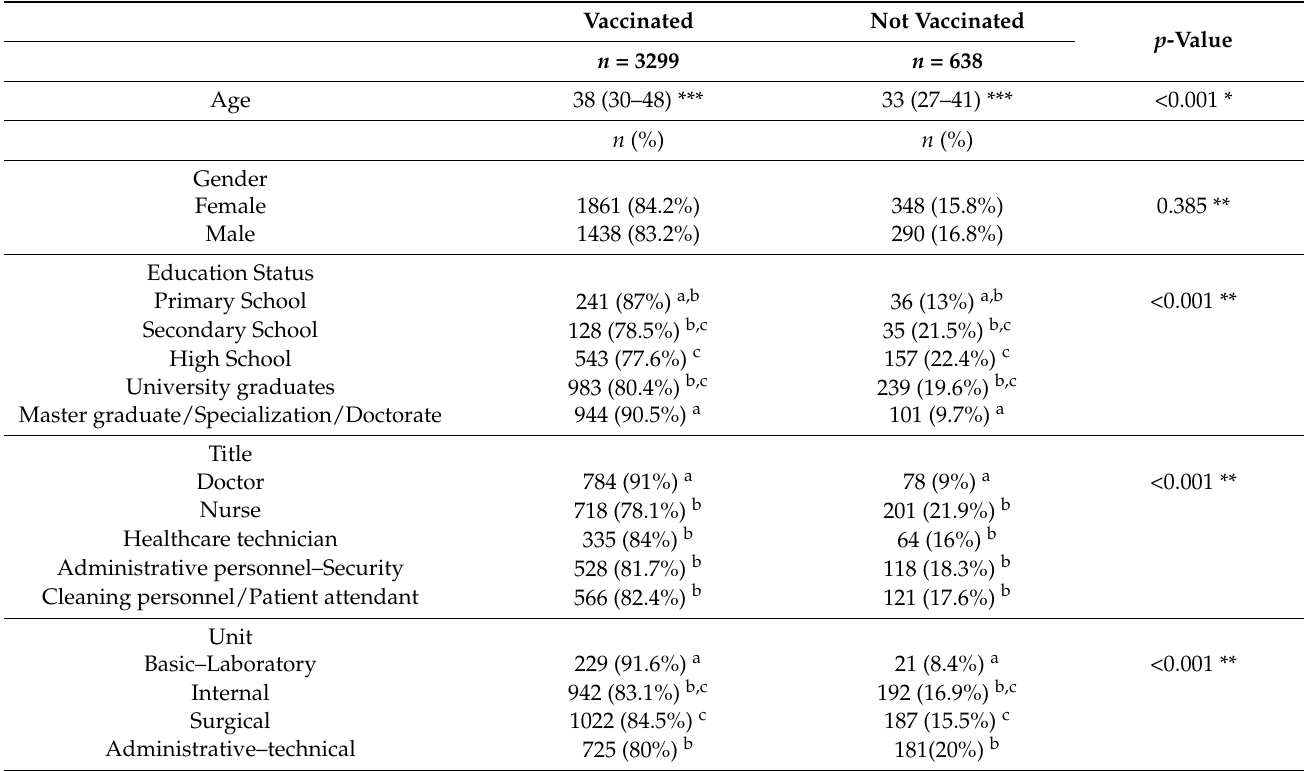
Table 1. Comparison of demographic characteristics concerning all personnel registered in the hospital according to their vaccination